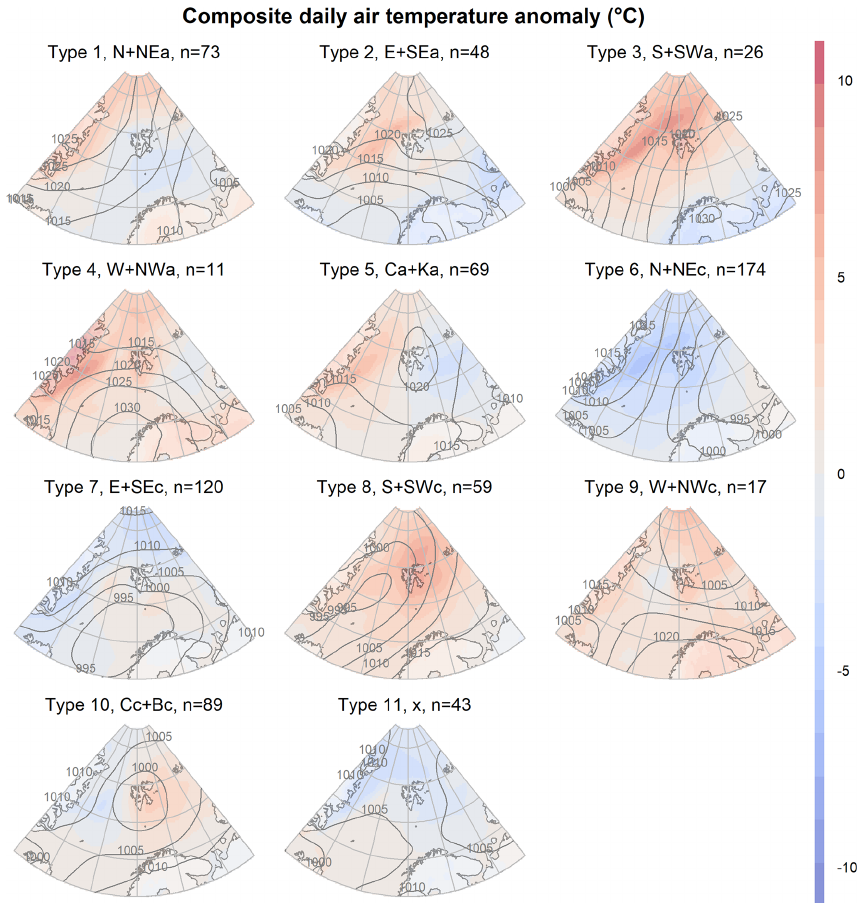
Figure A1. Composite daily mean air temperature anomaly by synoptic type, calculated versus mean daily air temperature conditions (Fig. B1). Composite MSLP isobars by synoptic type are included for